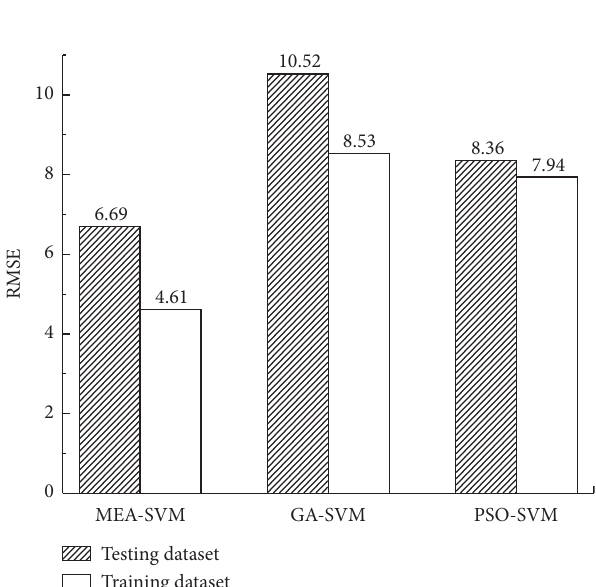
Figure 8: The RMSE of the models.